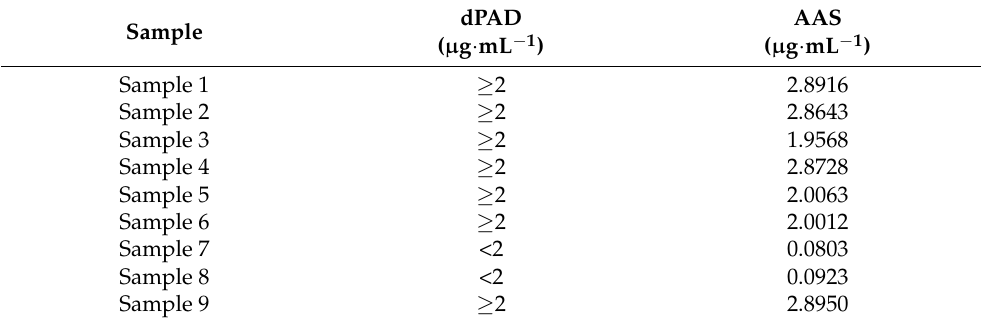
Table 2. Determination of Pb in blinded spiked century eggs on the dPAD compared to the concen- trations measured by atomic absorption spectroscopy